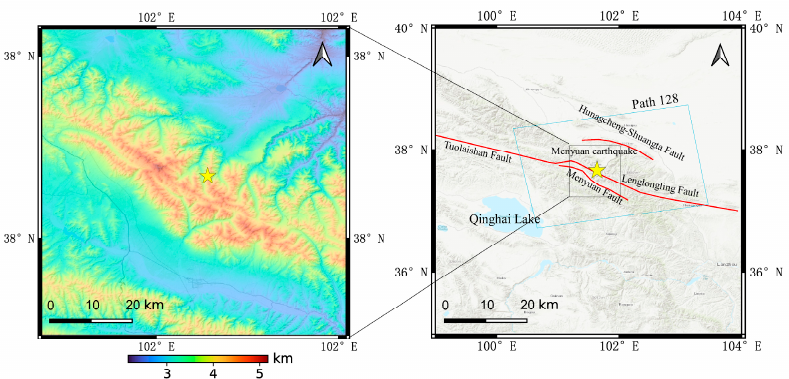
Figure 11. Reference map of the 21 January 2016 Menyuan Earthquake superimposed on topographic relief, with maximum elevation up to 5.17 km. The star shows the location of the 2016 Menyuan